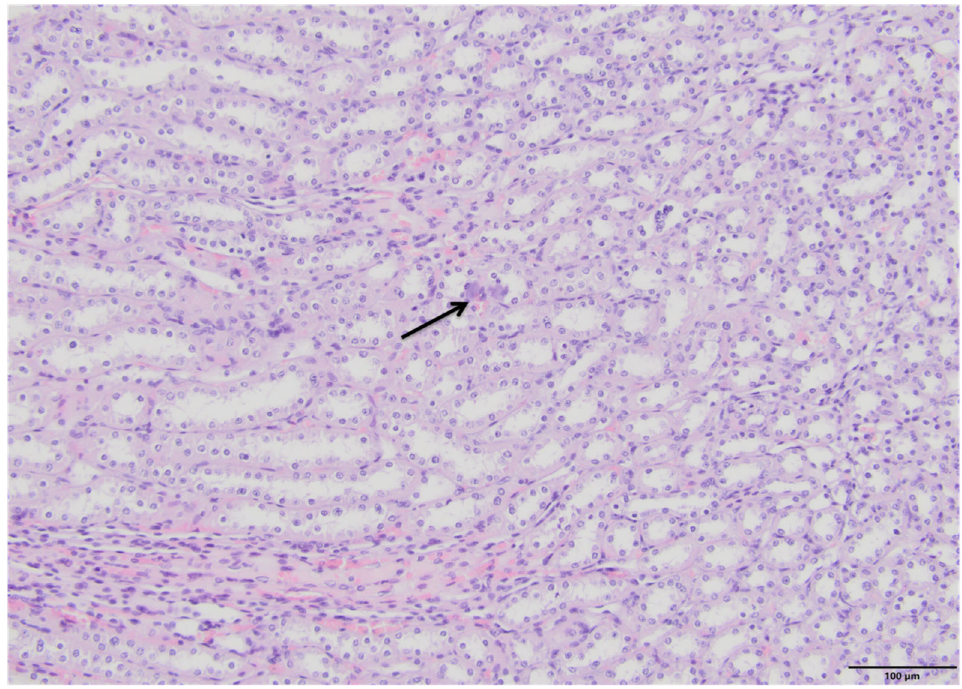
Figure 4. Pathological lesions in kidneys of rats on 60% fructose diet (F60). Two small basophilic interstitial and tubule-associated concretions in renal medulla (arrow). (HE, magnification 20 × ).